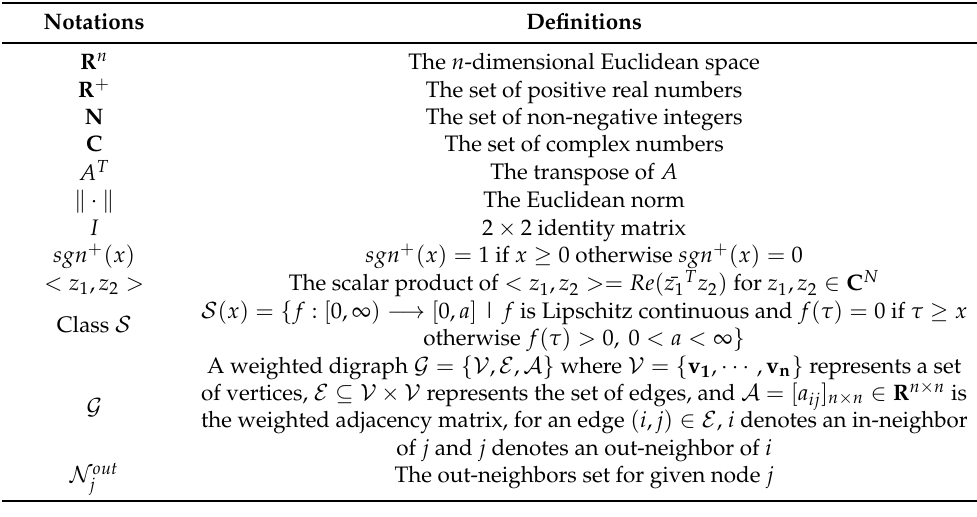
Table 1. Notations used in this